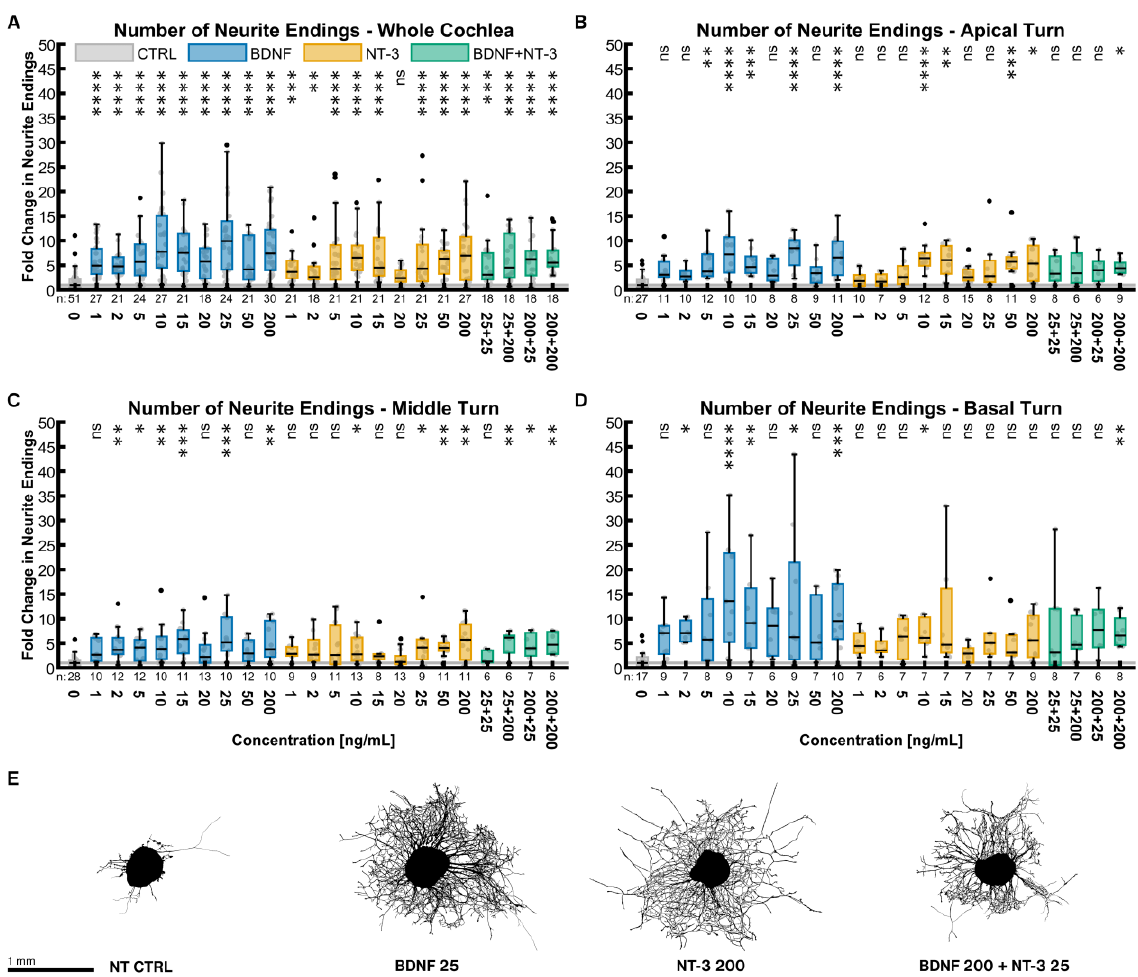
Figure 1. Number of neurite endings with neurotrophic supplementation. The diagrams ( A – D ) show the fold change of the number of neurite endings regarding the median of the NT control group with different neurotrophic supplementations. The groups in the first graph ( A ) contain an equal number of samples from three turns, hence representing the whole cochlea. Diagrams ( B – D ) depict the individual turns. ( A – D ) The boxes extend from the 25% to the 75% percentile. The black bar denotes the median. The whiskers delimit the 1.5-fold interquartile range. Samples within this range are marked as grey dots, and samples beyond this range are black. A grey line marks the median of the control group. The number of samples in each group is written right below the X-axis. The asterisks or ns (not significant) above the groups indicate the significance level of a Kruskal–Wallis test followed by a Dunn’s multi-comparison post-hoc test against the control group. ( E ) Representative explants at the median of the best-performing groups in ( A